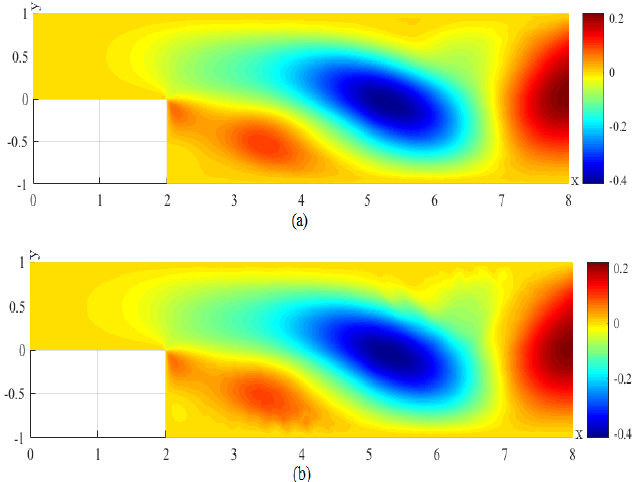
Figure 7. ( a ) The CNMFE solution for v at t = 6. ( b ) The RDRCNMFE solution for v at t = 6.